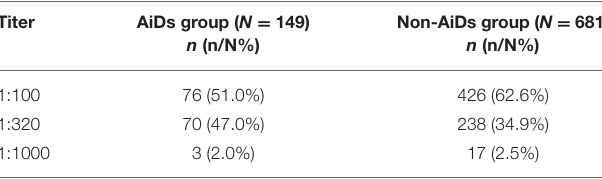
TABLE 3 | Titer distribution of ANA showing DFS pattern between AiDs group and non-AiDs